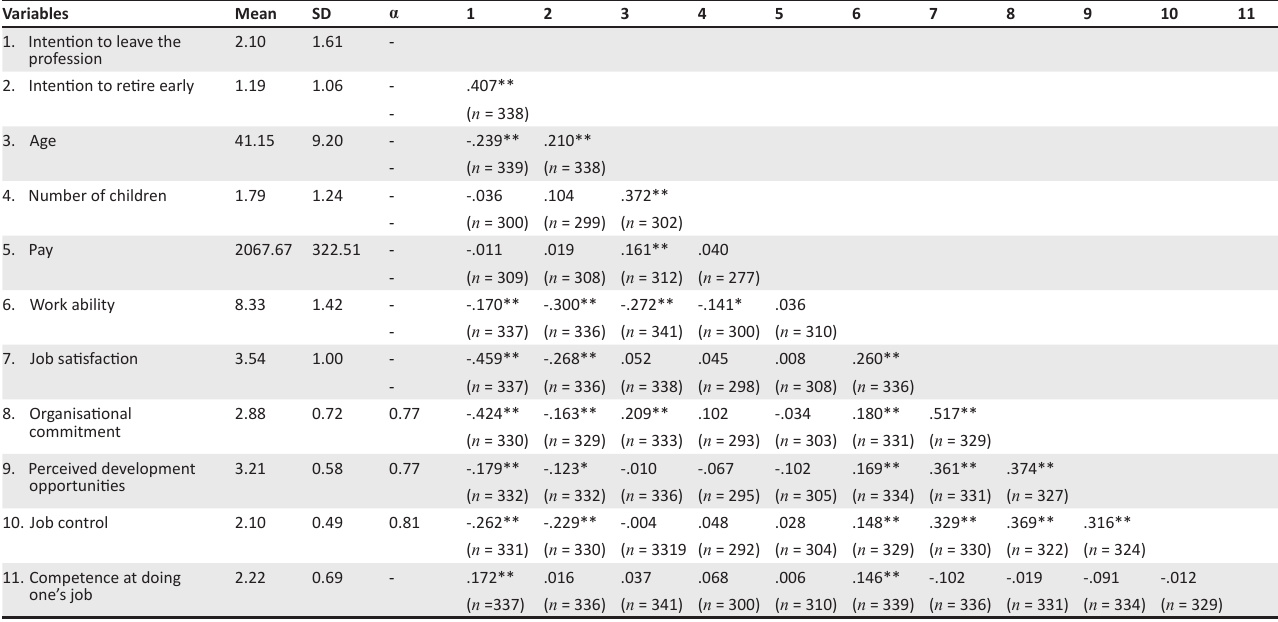
TABLE 3: Means, standard deviations, reliability estimates and bivariate correlations for the variables.